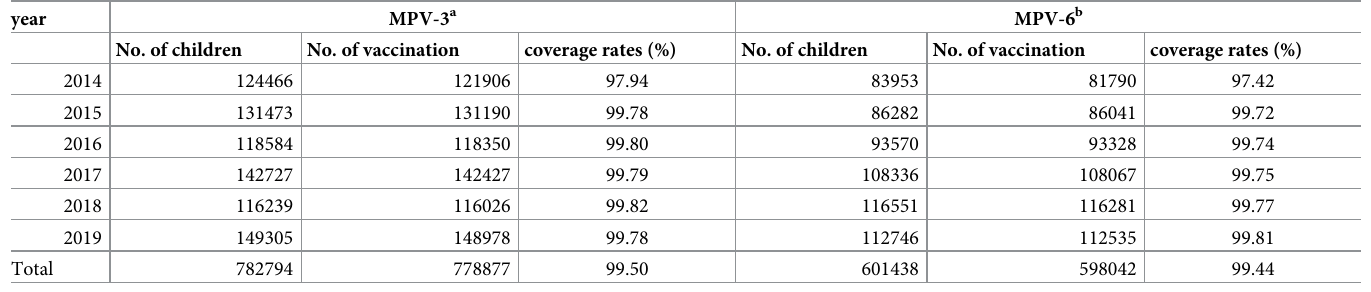
Table 1. Reported immunization coverage rates of MenV by dose from 2014 to 2019 in Hangzhou.